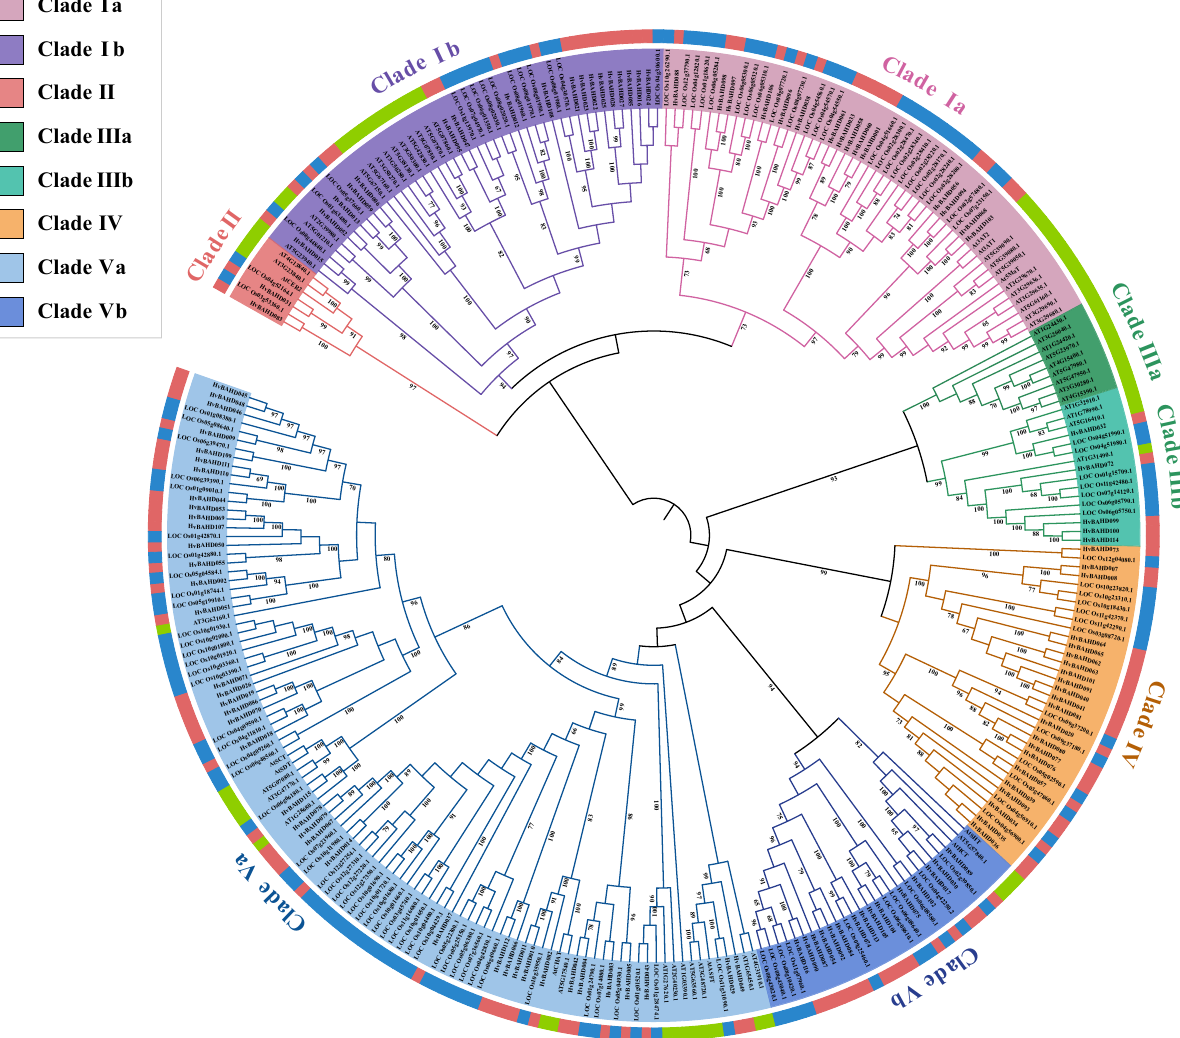
Figure 2. Phylogenetic analysis of BAHD proteins. The BAHD sequences of Arabidopsis thaliana , rice and barley were used to construct a phylogenetic tree using the maximum likelihood method. The sequences were divided into five clades. Different clades in the inner ring are distinguished by different colors, and different colors in the outer ring represent different species (green is Arabidopsis, red is barley, blue is rice). This phylogenetic tree was generated by MEGA X (https:// www. megas oftwa re. net/) and iTOL online site (https:// itol. embl.